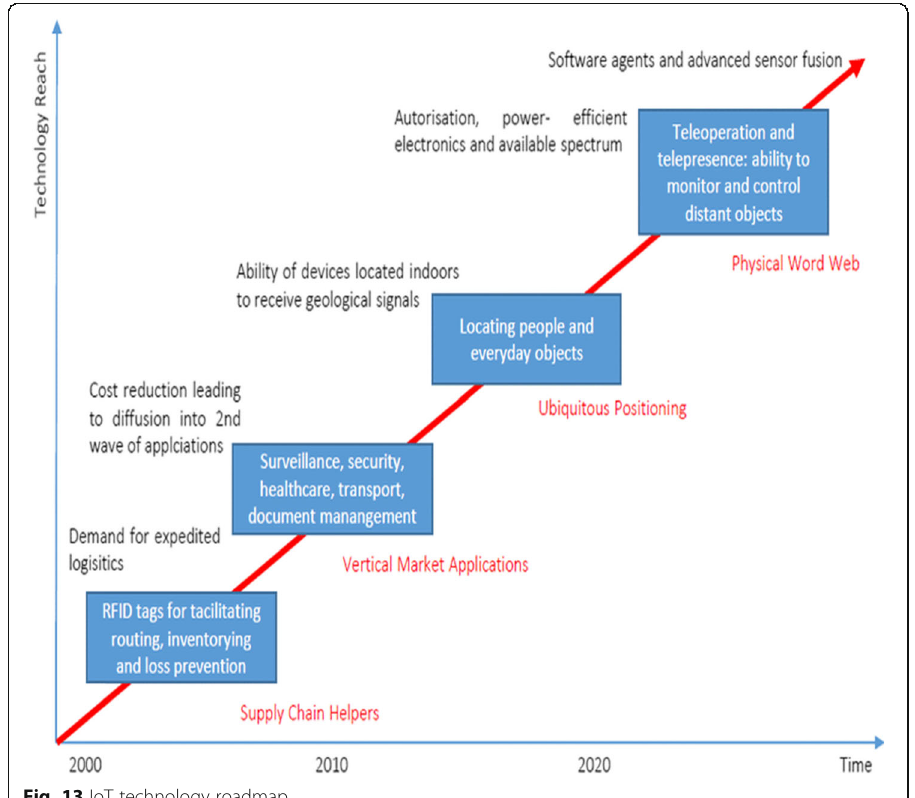
Fig. 13 IoT technology